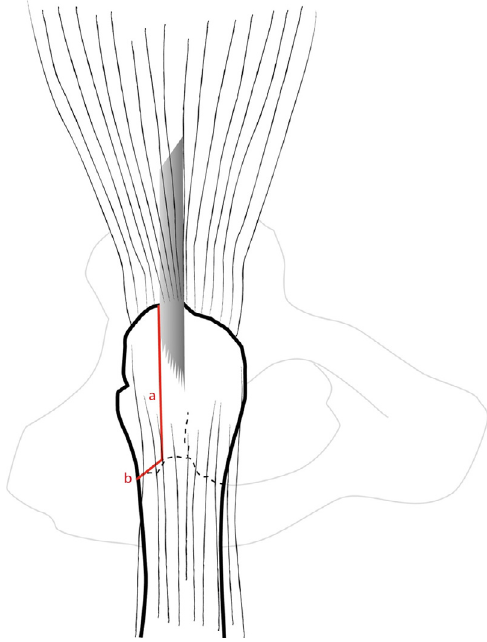
Figure 4. Coronal osteotomy of the great trochanter.